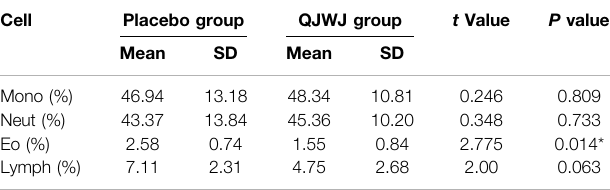
TABLE 5 | Induced sputum cell proportion between the two groups. Cell Placebo group